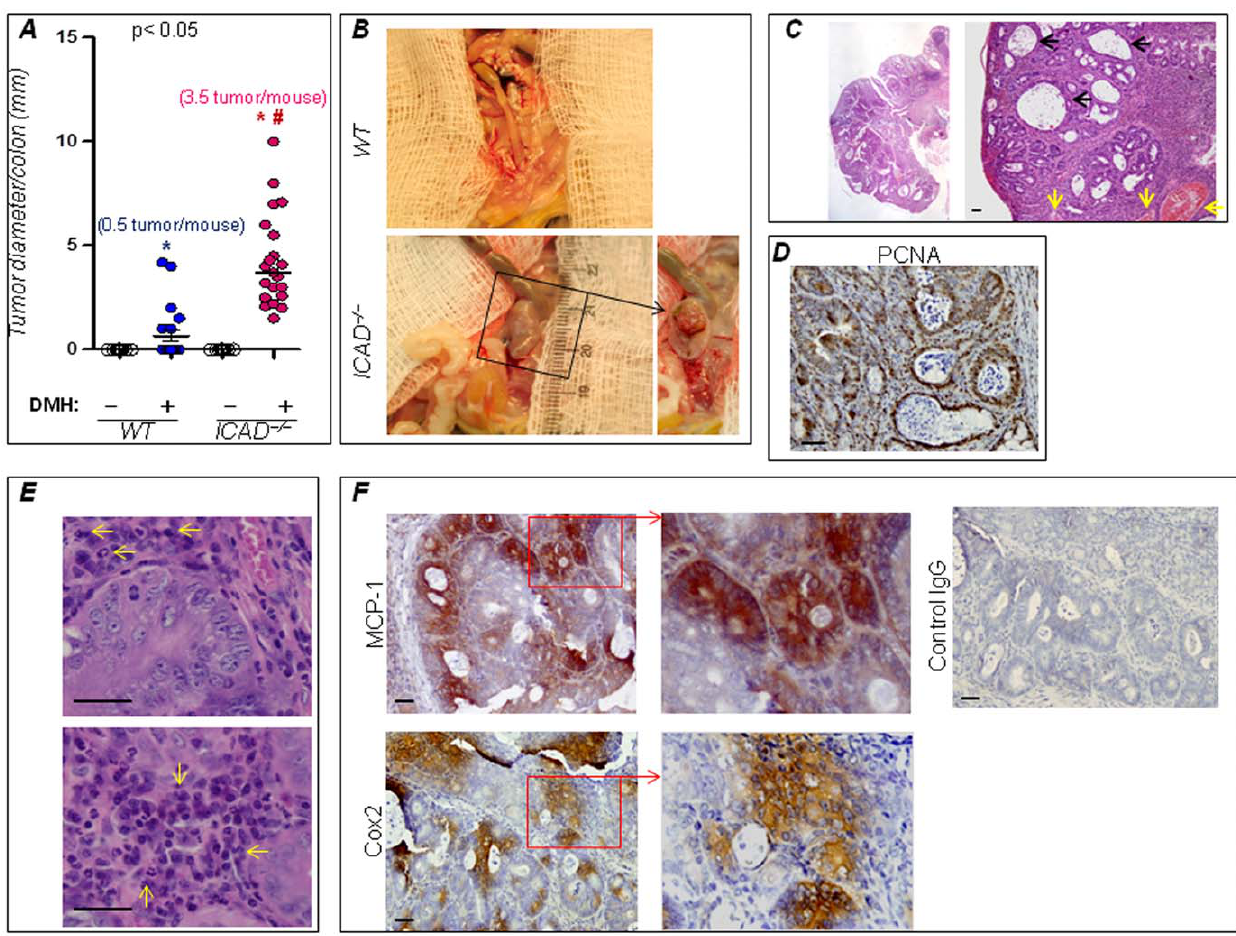
Figure 3. ICAD deficiency increases susceptibility to DMH-induced colon tumorigenesis. WT and ICAD 2 / 2 mice received DMH injections once a week for 8 weeks. Mice were sacrificed 24 weeks later. ( A ) Diameter of tumors was assessed in the different experimental groups; n=12. *, Difference from DMH-treated WT mice, p , 0.01. ( B ) A gross examination of a large tumor detected in DMH-treated ICAD 2 / 2 mice. ( C ) H&E-stained colonic tissue with a large tumor from a DMH-treated ICAD 2 / 2 mouse; note the large necrotic cores (black arrows) and vascularization (yellow arrows). ( D ) PCNA expression in colon tumors from DMH-treated ICAD 2 / 2 mice as assessed by IHC. ( E ) H&E-stained section with a tumor from a DMH- treated ICAD 2 / 2 mouse with inflammatory cells (arrows) in the vicinity of the tumor. ( F ) MCP-1 and COX2 expression in colon tumors from DMH- treated ICAD 2 / 2 mice as assessed by IHC; the right panel is an IgG control.